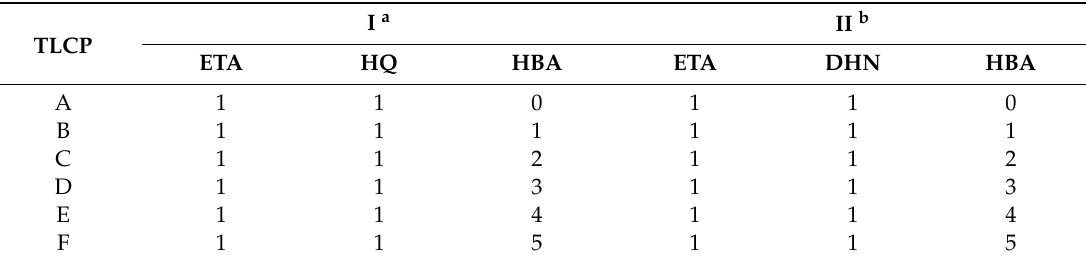
Table 1. Molar ratios of monomers in the